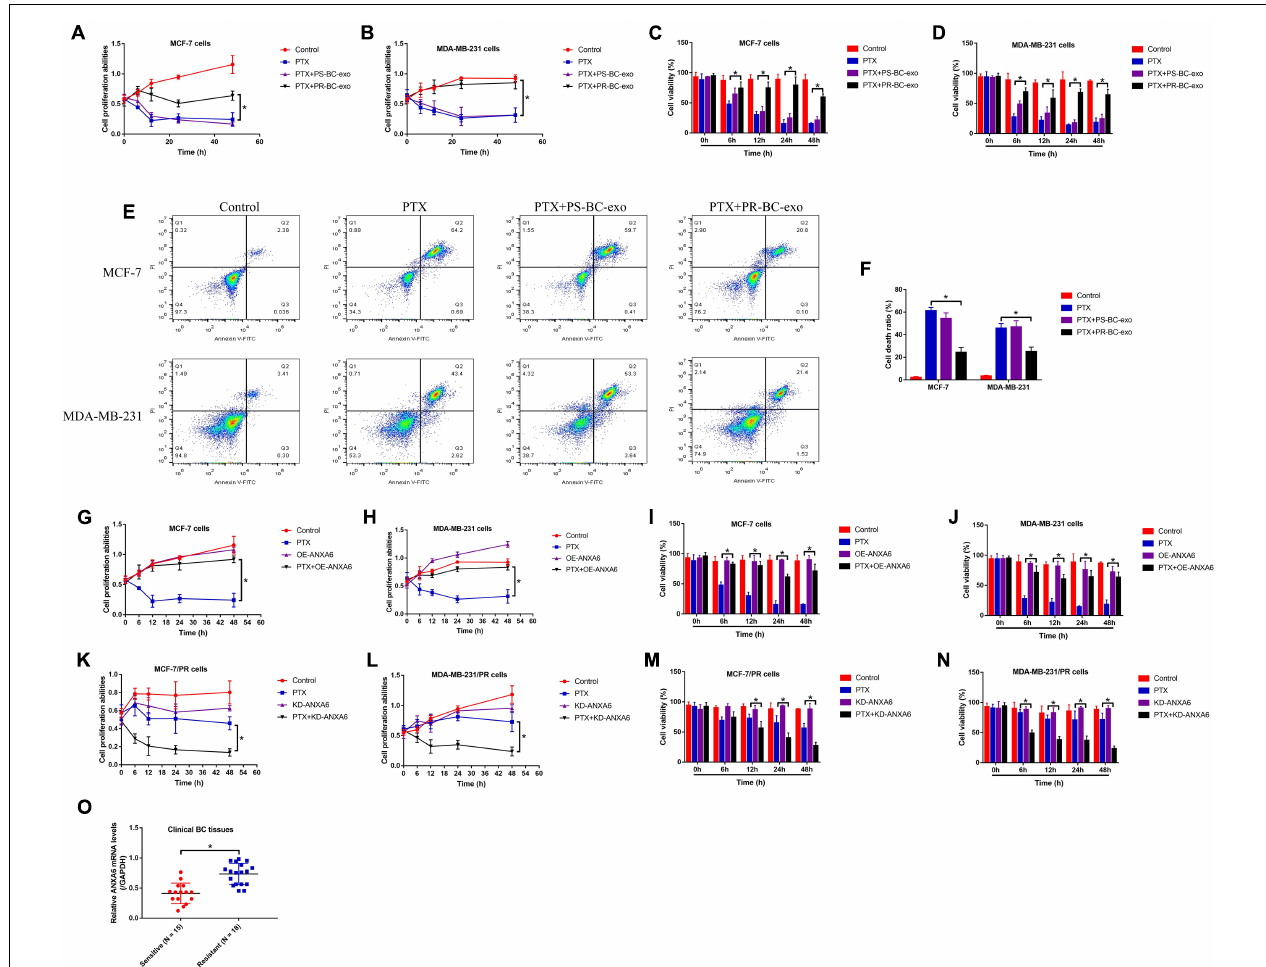
FIGURE 2 | BCSC-derived ANXA6-containing exosomes increased PTX resistance in PS-BC cells. The PS-BC cells were co-cultured with ANXA6 exosomes, and (A,B) MTT assay and (C,D) trypan blue staining assay were used to measure cell proliferation and viability. (E,F) BC cells were stained with PI and Annexin V-FITC, and FCM was subsequently used to examine cell death ratio. Cell proliferation and viability in (G–J) PS-BC cells and (K–N) PR-BC cells were, respectively, examined. (O) The mRNA levels of ANXA6 in BC tissues were measured by real-time qPCR. A single experiment had three repetitions, and * p < 0.05 was regarded as statistical